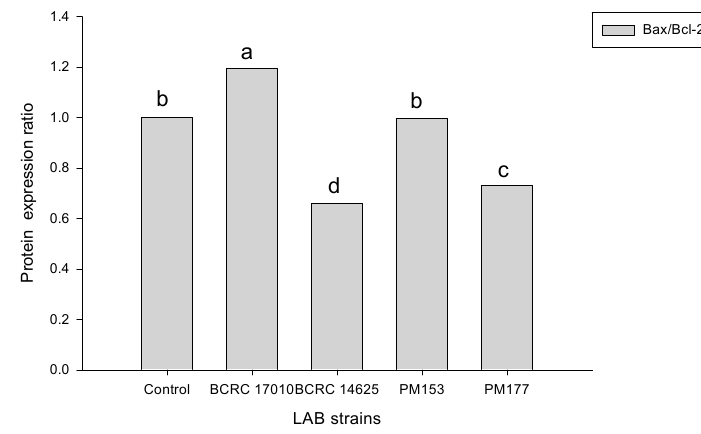
Figure 4. Four lactic acid bacteria (10 9 cfu/mL) in HT-29 for 8 h after on the level of Bax/Bcl-2 in HT-29 cell line. The control means untreated cells. a–d Values with different symbols are significantly different at the level of p < 0.05 by One-way ANOVA.